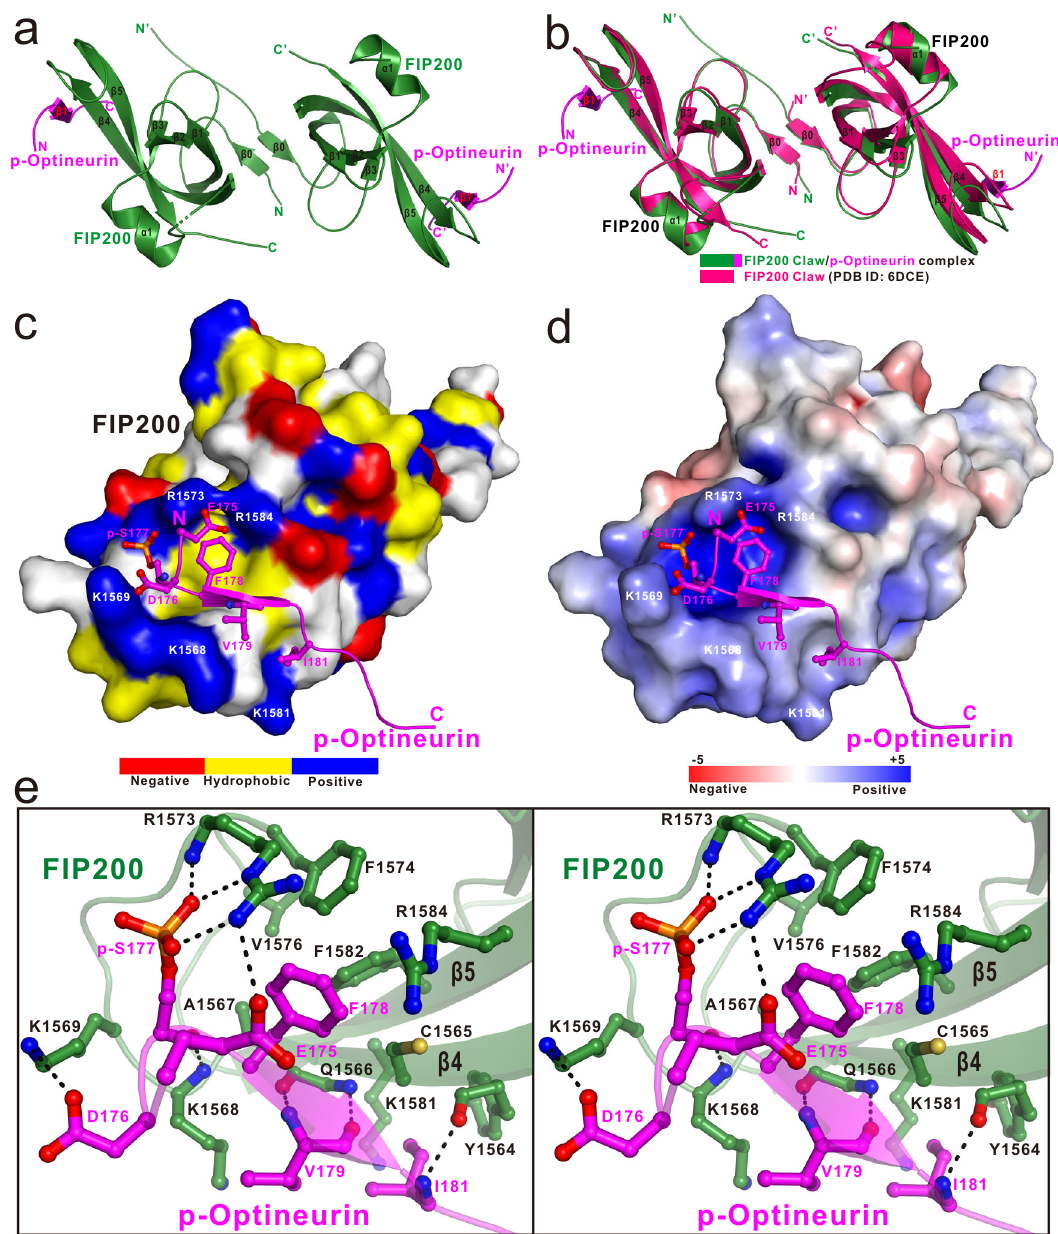
Fig. 4 The structural analyses of FIP200 Claw/p-Optineurin LIR complex. a Ribbon diagram showing the overall structure of the dimeric FIP200 Claw/p- Optineurin LIR complex. In this drawing, p-Optineurin stands for the phospho-Optineurin LIR motif. Meanwhile, the two FIP200 Claw molecules are colored in green, while the two bound p-Optineurin LIR are colored in magenta. b The comparison of the overall structures of the FIP200 Claw/p-Optineurin LIR complex (green-magenta) with the apo-form FIP200 Claw dimer (hot pink, PDB ID: 6DCE). c The combined surface representation and the ribbon-stick model showing the hydrophobic binding surface between FIP200 Claw and p-Optineurin LIR. In this drawing, the p-Optineurin LIR is displayed in the ribbon-stick model, and the FIP200 Claw domain is showed in surface representation colored by amino acid types. Speci fi cally, the hydrophobic amino acid residues in the surface model of FIP200 Claw are drawn in yellow, the positively charged residues in blue, the negatively charged residues in red, and the uncharged polar residues in gray. d The combined surface charge representation and the ribbon-stick model showing the charge – charge interactions between FIP200 Claw and p-Optineurin LIR in the complex structure. e Stereo view of the ribbon-stick model showing the detailed interactions between the Claw domain of FIP200 and p-Optineurin LIR. The hydrogen bonds and salt bridges involved in the interaction are shown as dotted lines. phosphate group of the acidic p-S177 preceding the crucial R1573 further contributes to the p-CCPG1 FIR2/FIP200 Claw hydrophobic residue that occupies the LHP of FIP200 Claw is complex formation (Fig. 4d, e). Importantly, in line with our coupled with the FIP200 R1573 residue by forming two speci fi c structural data, further analytic gel fi ltration chromatography- salt bridges and one hydrogen bond, while the side-chain based analyses revealed that point mutations of key interface carboxyl group of Optineurin D176 forms a salt bridge with the residues including the Y1564S, K1569A, R1573E, F1574Q side chain of K1569 from FIP200 (Fig. 4c – e). In addition, a mutations of FIP200 and the D176R, F178Q mutations of charge – charge interaction between Optineurin E175 and FIP200 the phosphomimetic Optineurin(169 – 185) S177E mutant all NATURE COMMUNICATIONS| (2021) 12:1570